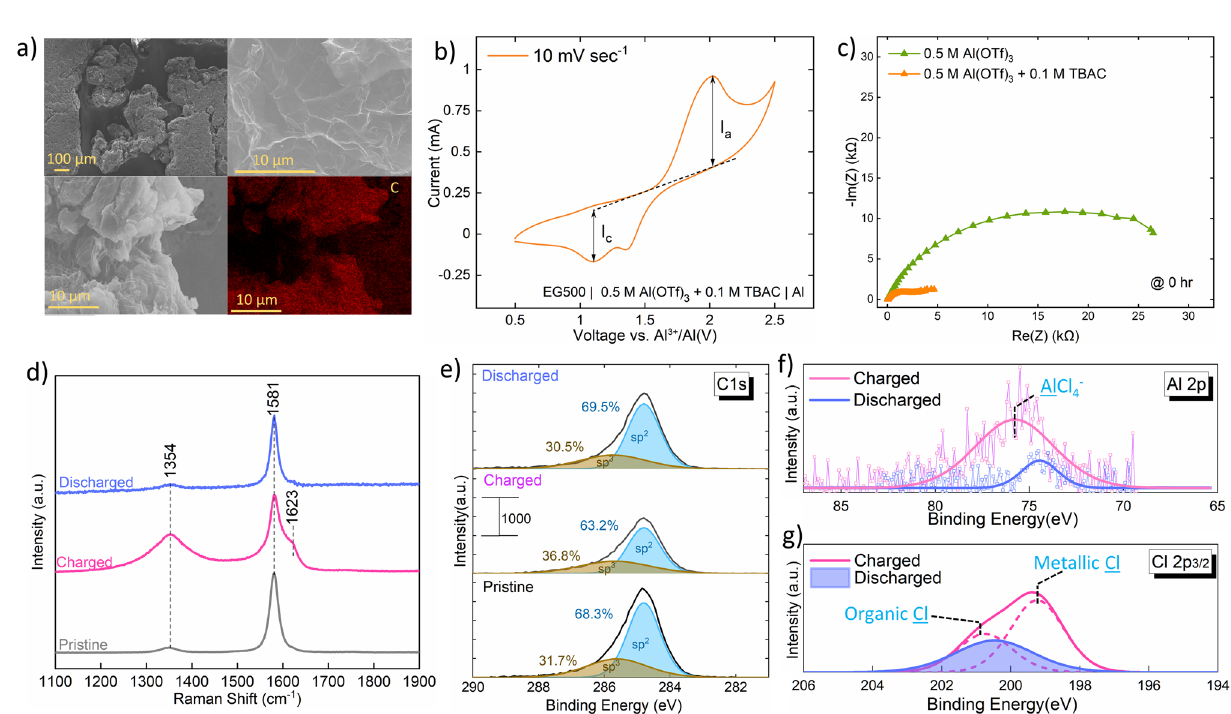
Fig. 6 a SEM micrograph and EDX map of commercially obtained EG500. b Cyclic voltammogram of full-cell—EG500 | 0.5 M Al(OTf) 3 + 0.1 M TBAC | Al at 10 mV sec. −1 . c Nyquist plots collected for Al symmetric cell, comparing 0.5 M Al(OTf) 3 and 0.5 M Al(OTf) 3 + 0.1 M TBAC right after cell fabrication. d Ex-situ Raman spectra for pristine, charged and discharged EG500. e C 1 s region of XPS spectra for the pristine, charged and discharged EG500. f Al 2 p and g Cl 2 p region of XPS spectra for the charged and the discharged